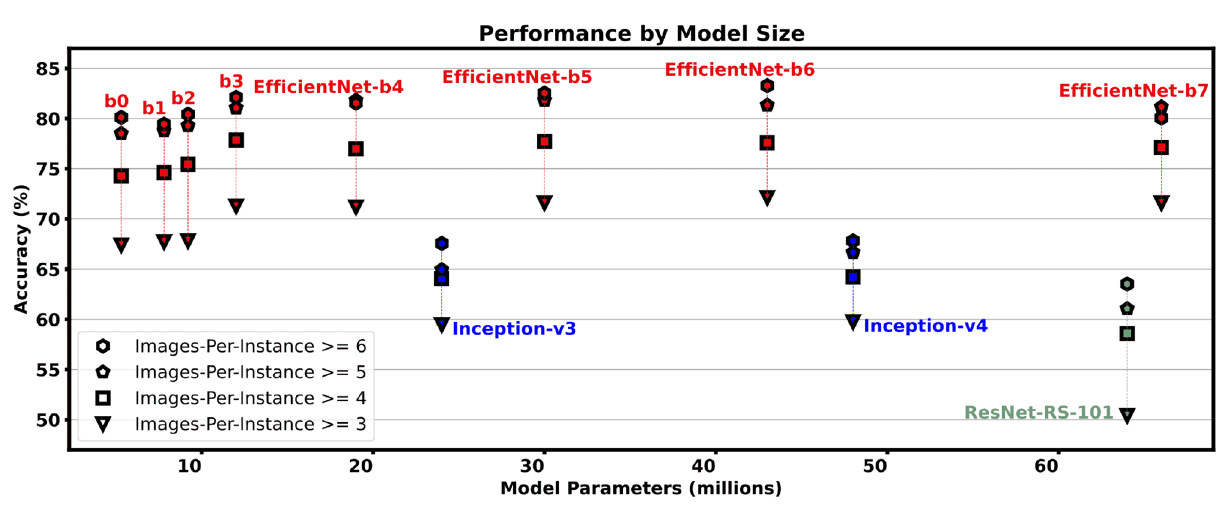
Figure 5. Performance of models with respect to it’s size i.e. the number of parameters. The four dataset image- per-instance scenarios here are the same four scenarios as in Fig. 4.